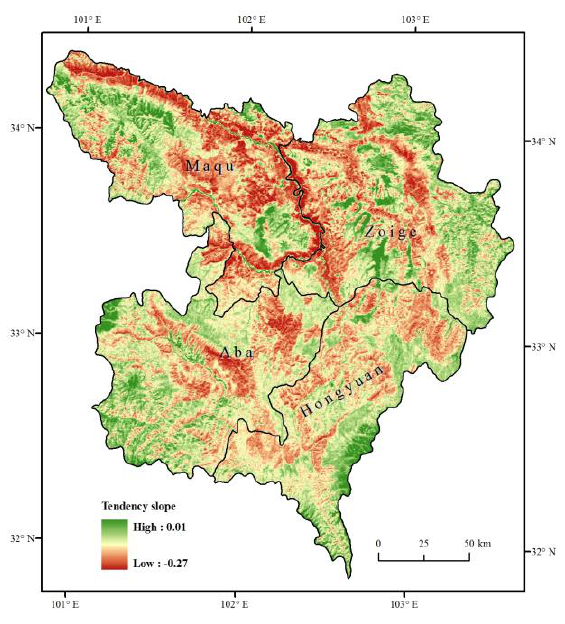
Figure 3. Spatial pattern of EVI change tendency in Zoige